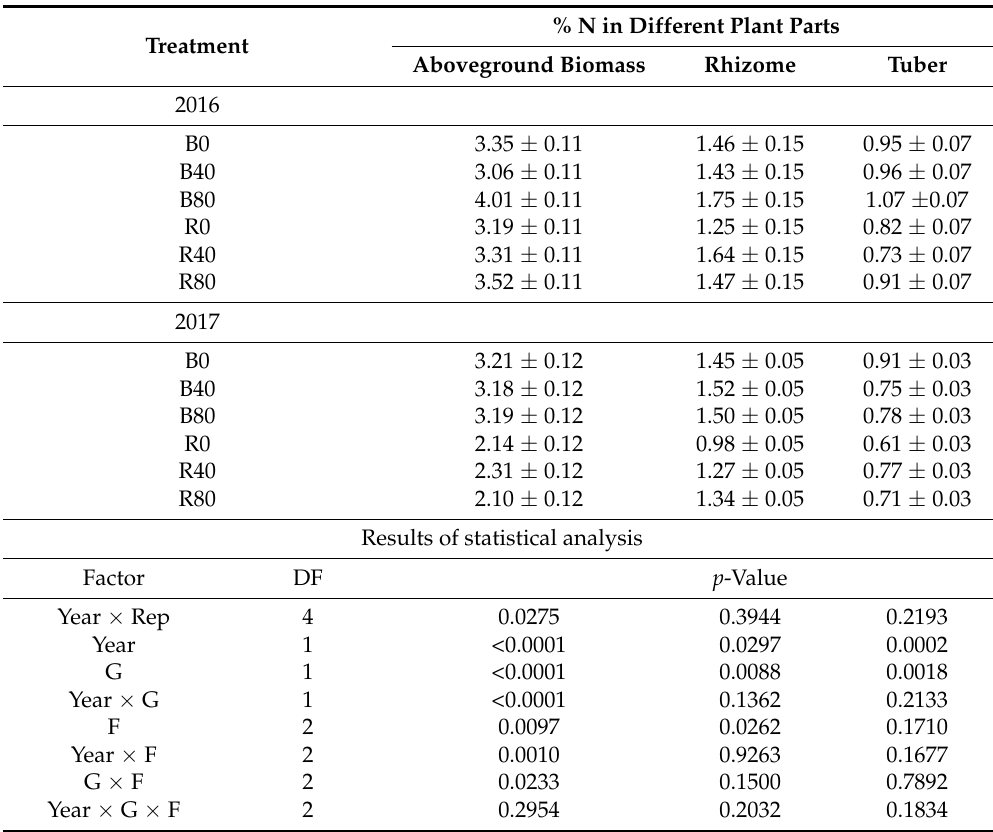
Table 5. Nitrogen concentration (%) in the aboveground biomass of rhizome and tuber at the last destructive measurement (161 and 165 DAP) immediately before harvest for two years (2016 and 2017) of the six treatments (B0, B40, B80, R0, R40, and R80), notated as the mean value ± standard error. % N in Different Plant Parts Treatment Aboveground Biomass Rhizome